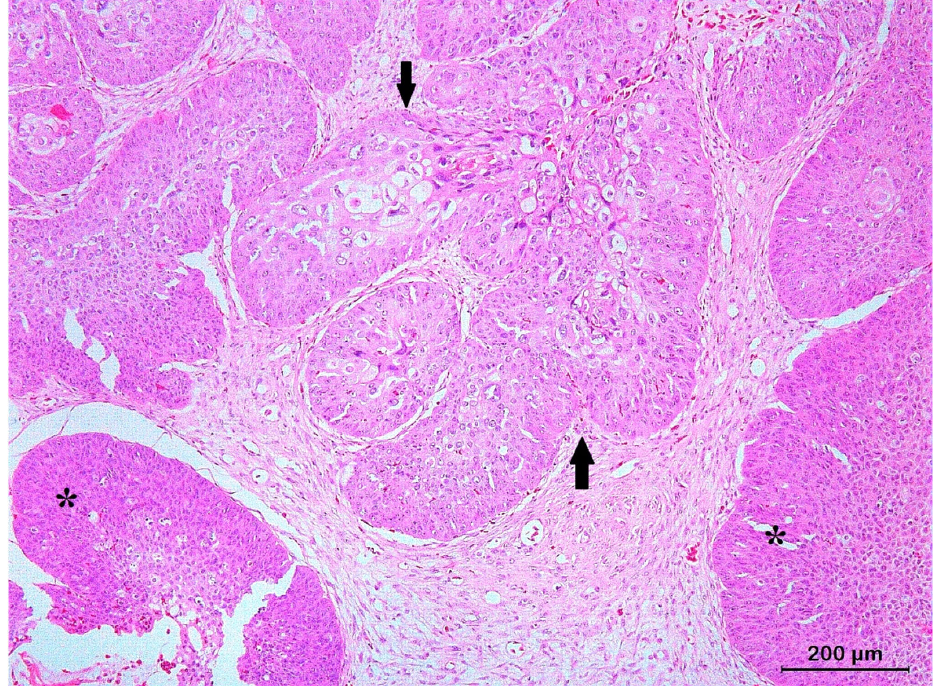
Figure 8. Histological section of a basosquamous cell carcinoma originating from the epidermis of the shell of a Hermann’s tortoise ( Testudo hermanni ) presenting as an invasive front showing BCCs (asterisks) as well as SCCs (arrows) histological features.